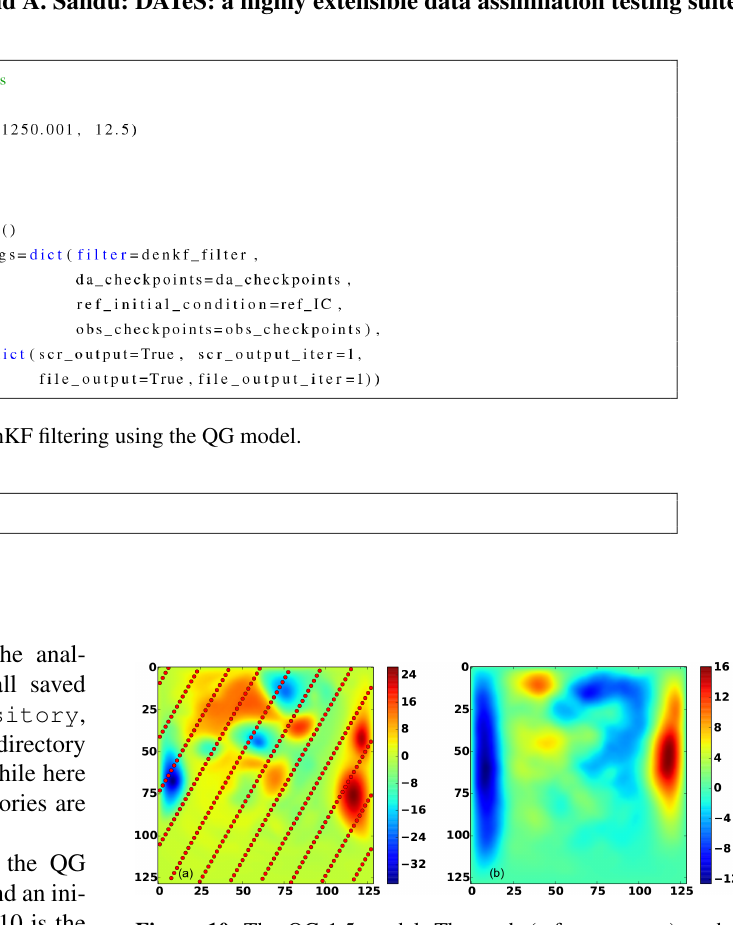
Figure 10. The QG-1.5 model. The truth (reference state) at the initial time ( t = 0) of the assimilation experiment is shown in panel (a) . The red dots indicate the locations of observations for one of the test cases employed. The initial forecast state, taken as the av- erage of the initial ensemble at time t = 0, is shown in panel (b) .